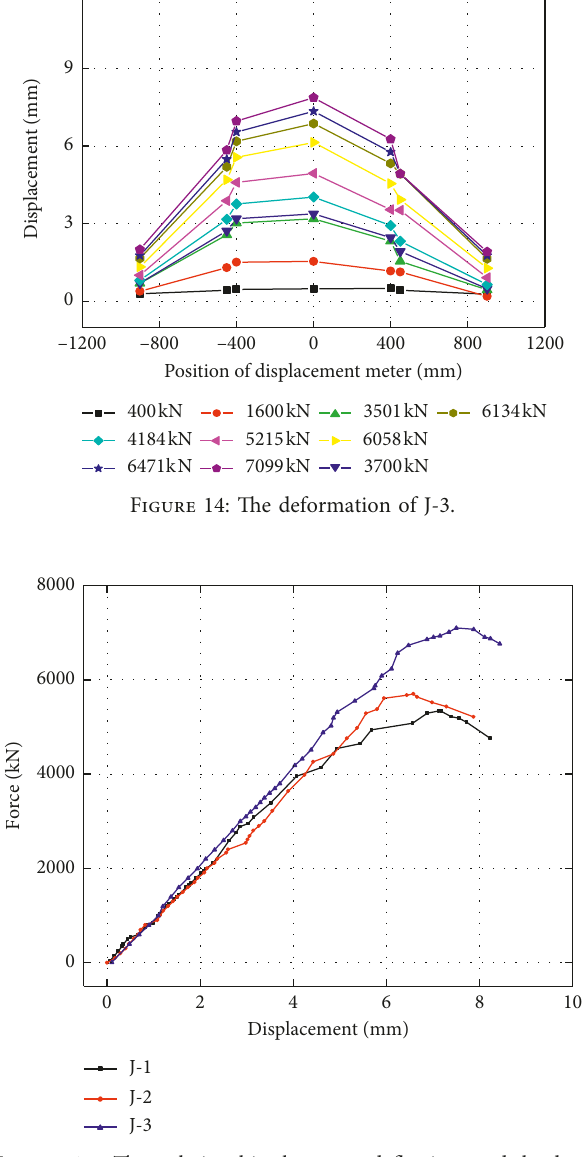
Figure 15: The relationship between deflection and load of specimens. Table 4: Bearing capacity and failure mode of the specimen. Specimen